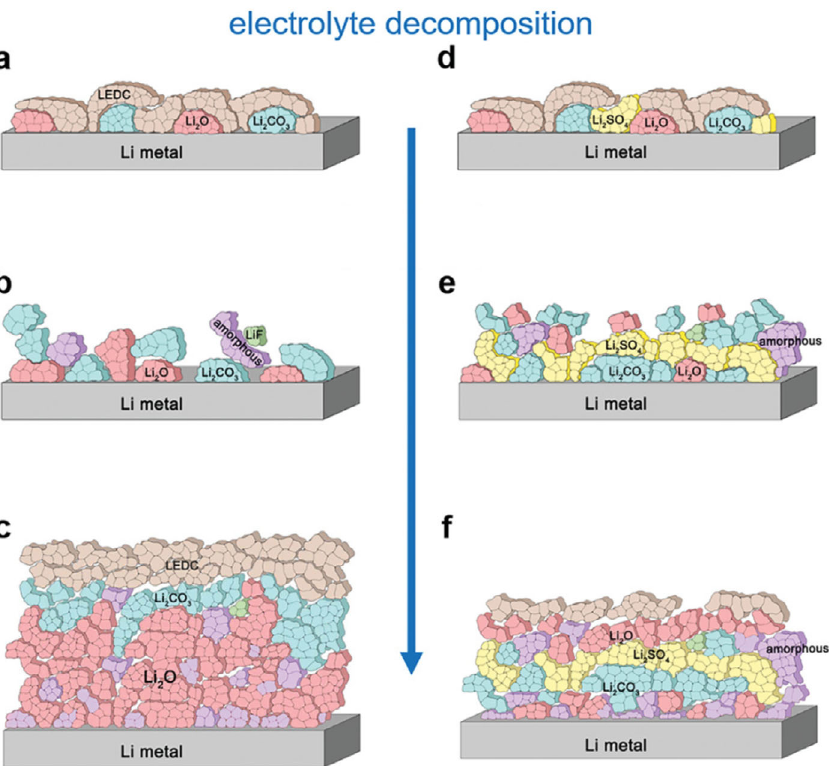
Fig. 1 Schematic representation of SEI formation on a lithium metal electrode. Panels a – c show SEI evolution without additives in the ethylene diethyl carbonate electrolyte. Due to continuous decomposition of the formed lithium ethylene dicarbonate (LEDC) and lithium carbonate (Li 2 CO 3 ), lithium oxide (Li 2 O) accumulates and covers the electrode. Panels d – f depict the effects of ethylene sulfate as an electrolyte additive. Lithium-sulfur species such as Li 2 SO 4 form a layer (yellow) preventing further decomposition of Li 2 CO 3 . Reproduced from Adv. Mater . 2100404 (2021), copyright (2021) Wiley ‐ VCH GmbH